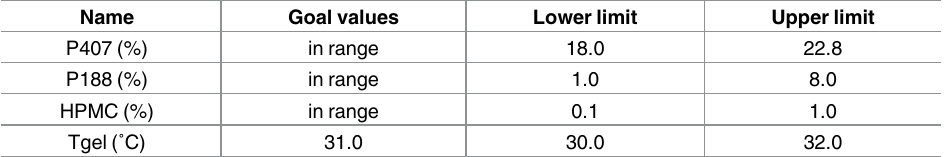
Table 6. Criteria for the optimized formulations.